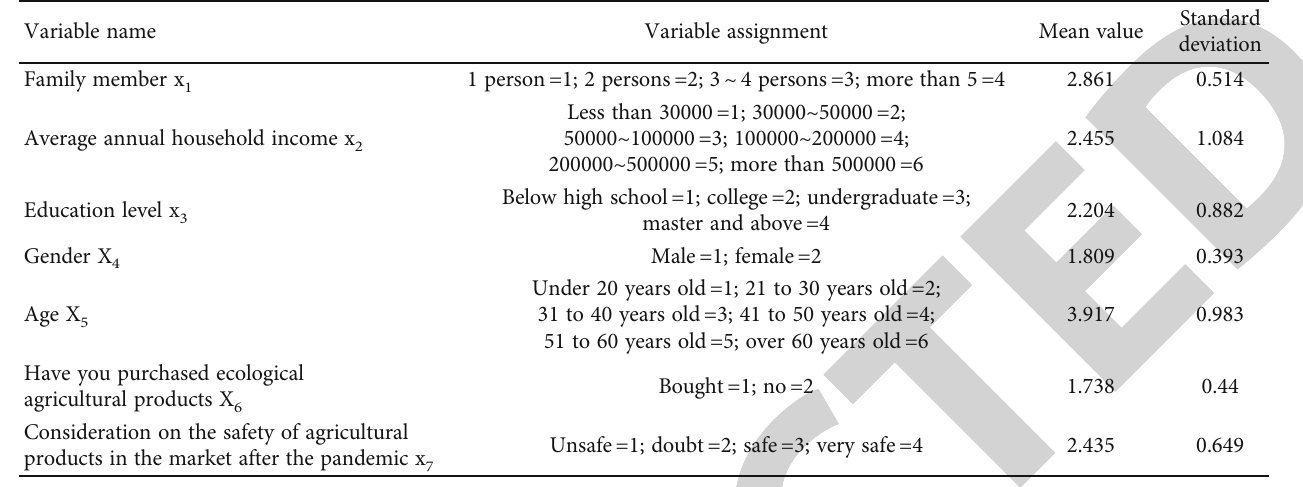
Table 5: Related variables and mean values.